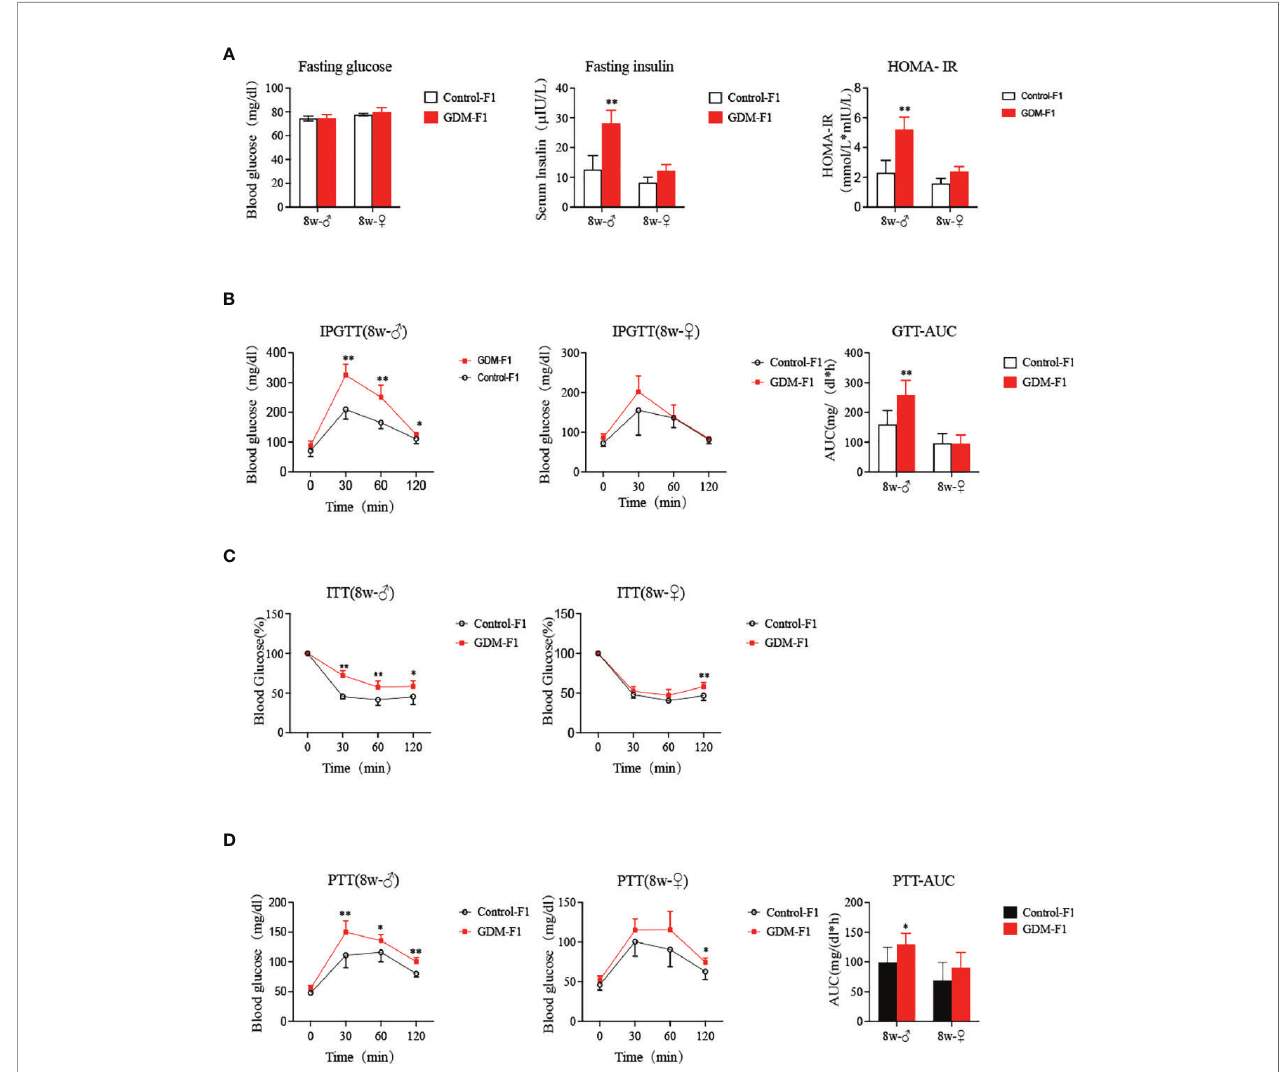
FIGURE 2 | Glucose Homeostasis on GDM-F1 and control-F1 mice. (A) fasting serum glucose concentration, fasting insulin concentration, HOMA-IR of 8-week-old F1 offspring; (B) Glucose tolerance test (GTT, 2 g/kg glucose ip) and Area under the curve (AUC) of 8-week-old F1 offspring over the course of 120 min; (C) insulin tolerance test (ITT, 0.75 U/kg insulin ip) of 8-week-old F1 offspring over the course of 120 min; (D) Pyruvate tolerance test (PTT, 2g/kg pyruvate ip) and AUC of 8- week-old F1 offspring over the course of 120 min; data are presented as mean ± SD, * P < 0.05. ** P < 0.01, n = 6 mice per group. Signi fi cance was determined by Student t